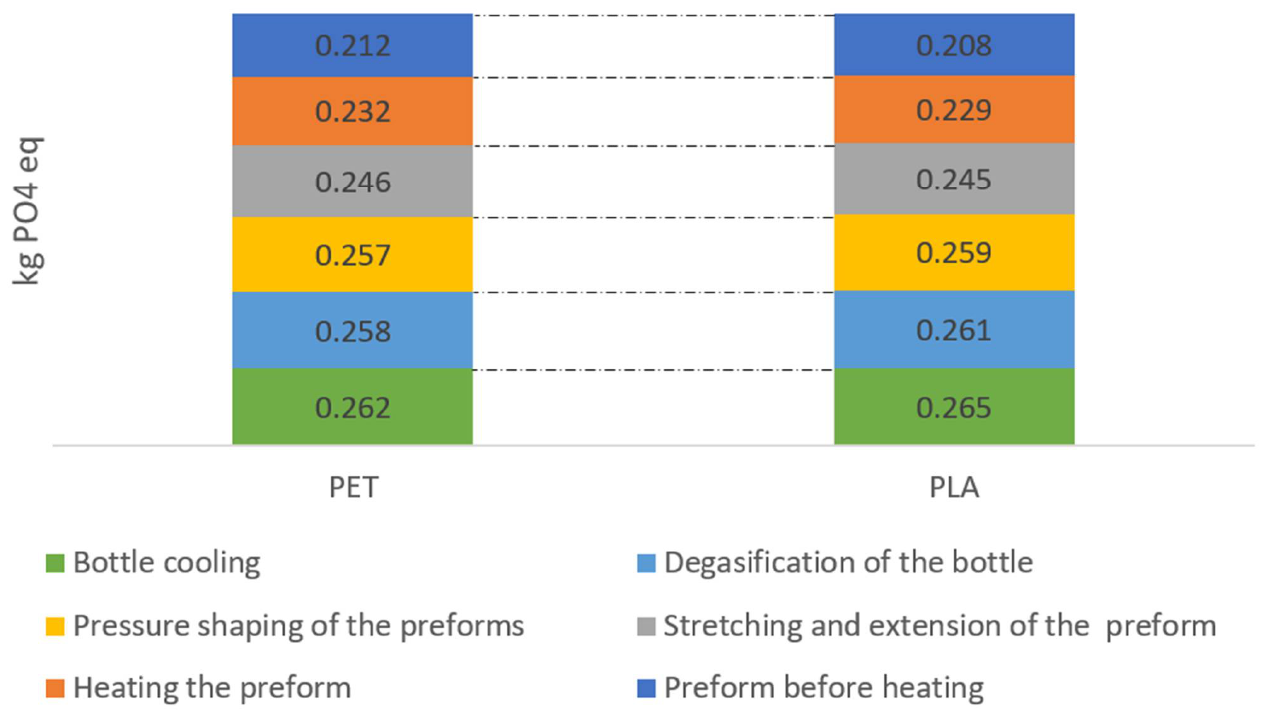
Figure 5. Eutrophication emissions throughout the entire bottle shaping process. The share of biodegradable plastic in the bottle shaping process has a positive effect on the size of gas emission indicators. The value of the greenhouse gas emission index preform before the heating process is about 6.57 g CO 2 /1000 bottles for all PET bottle, while with PLA material, this value is reduced to about 4.04 g CO 2 /1000 bottles (Figure 6). The total CO 2 emission from PLA production is higher than PET. The results show that both energy consumption and CO 2 emissions would increase significantly if plastic products were to be replaced by those made of biodegradable materials under appropriate conditions. The examples of bottles made of PLA and their comparison with PET bottles show a large impact of bottle forming conditions and overall life cycle GHG performance. With current waste management solutions, PET bottles contribute less to global warming than bottles made of PLA. If plastic bottles are not disposed of in landfills, the results may be quite different. Depending on the waste management method used, the difference between the minimum and maximum CO 2 equivalent emissions can be significant.